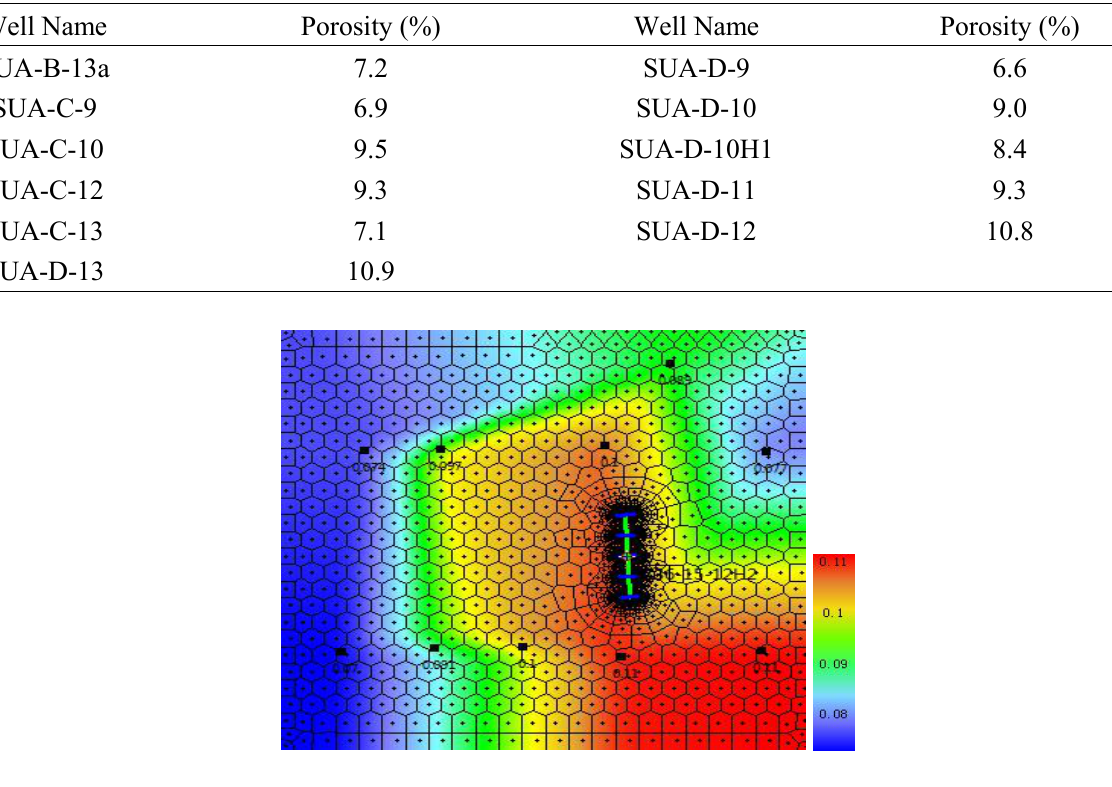
Figure 8—Porosity distribution of SuA-B-CH2 wells.